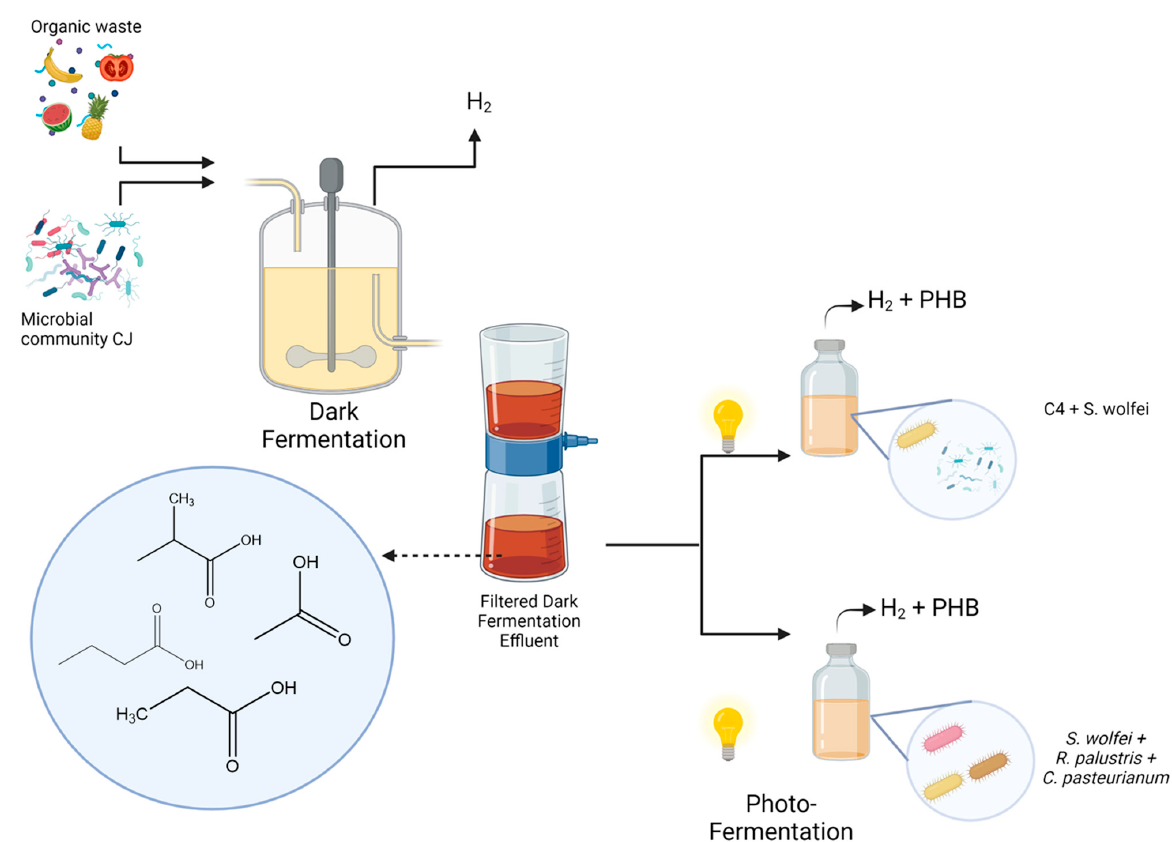
Figure 1. Fermentation strategy. During the dark fermentation stage, organic wastes were used to produce H2 and organic acids. The effluent was then filtered and used as substrate for the photofermentation in serum bottles. Created with BioRender.com.